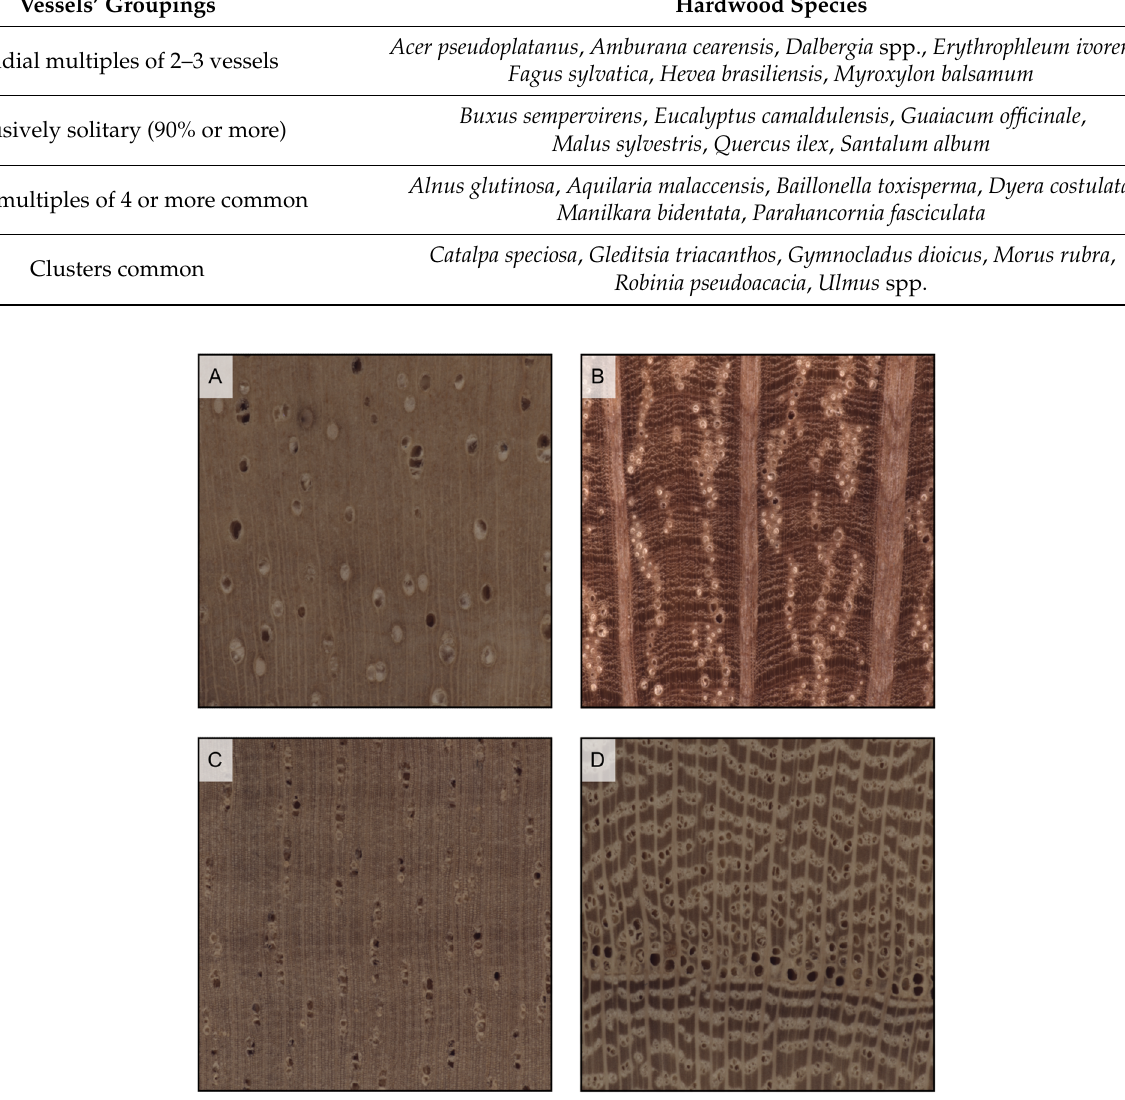
Figure 13. Vessels’ groupings (transverse sections). ( A ) in radial multiples of 2 – 3 vessels ( Hevea brasiliensis ); ( B ) exclusively solitary ( Quercus ilex ); ( C ) radial multiples of 4 or more common ( Dyera costulata ); ( D ) clusters common ( Celtis occidentalis ).